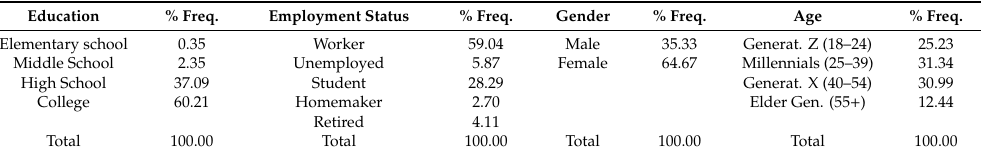
Table 2. Sample demographics characteristics.